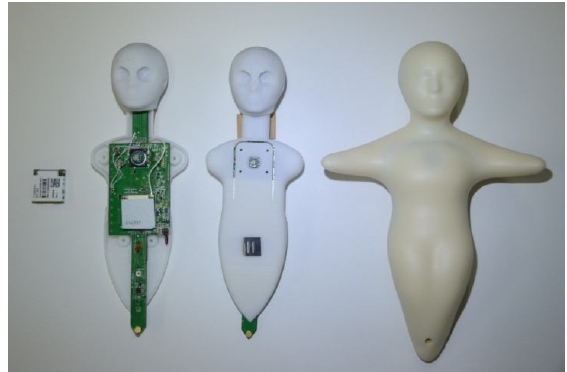
Figure 1. The prototype of cellphone-type android